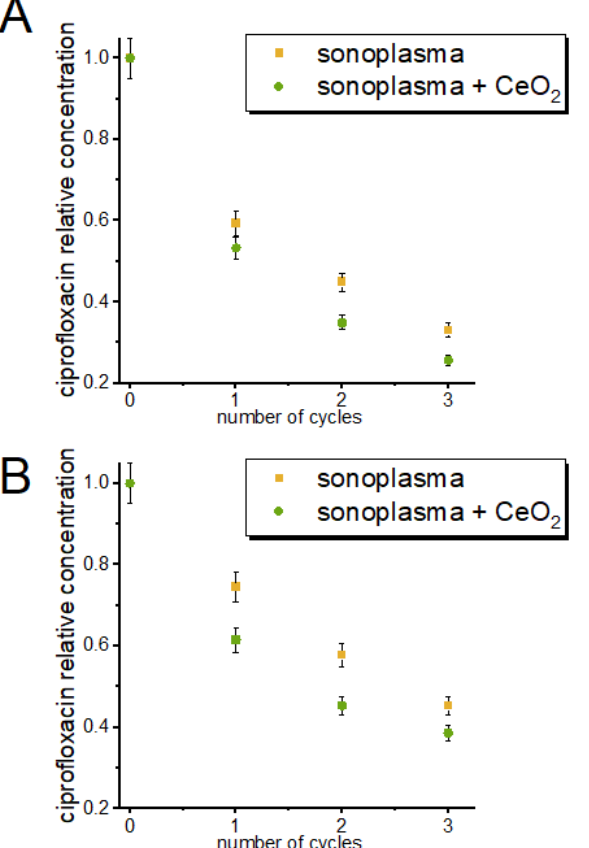
Figure 3. Change in the concentrations of tetracycline ( A ) and ciprofloxacin ( B ) in solution with the number of sonoplasma treatment cycles.